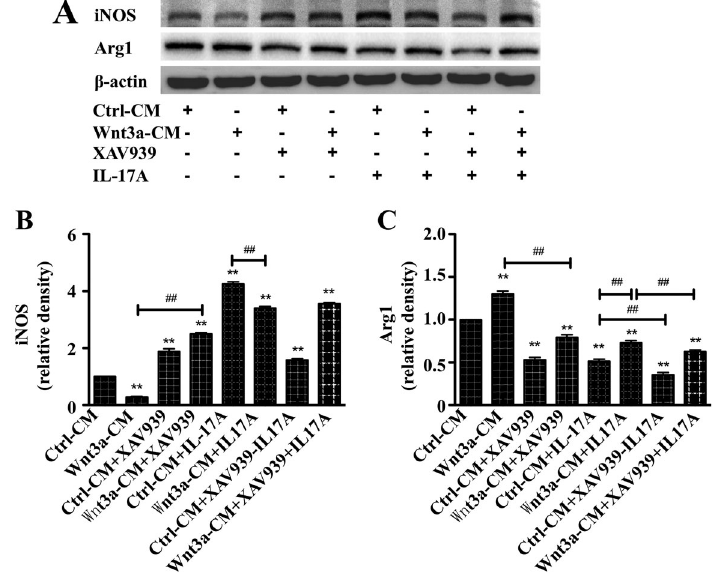
Figure 2. Interleukin (IL)-17A reversed the Wnt3A-altered expression of macrophage polarization markers in murine macrophage RAW264.7 cells. A , Representative images of immunoblots of Arg1 and iNOS in cells treated with different conditions. B and C , Semi- quantitative analysis of the expression of proteins in ( A ) showing fold-changes of Arg1 and iNOS in cells treated with Wnt3a-CM and/or XAV939 with or without rhIL-17A as determined by densitometry assay using ImageJ software Fiji. Data are reported as means ± SD from three independent experiments. **P o 0.01 compared to the Ctrl-CM group; ## P o 0.01 compared to the indicated groups